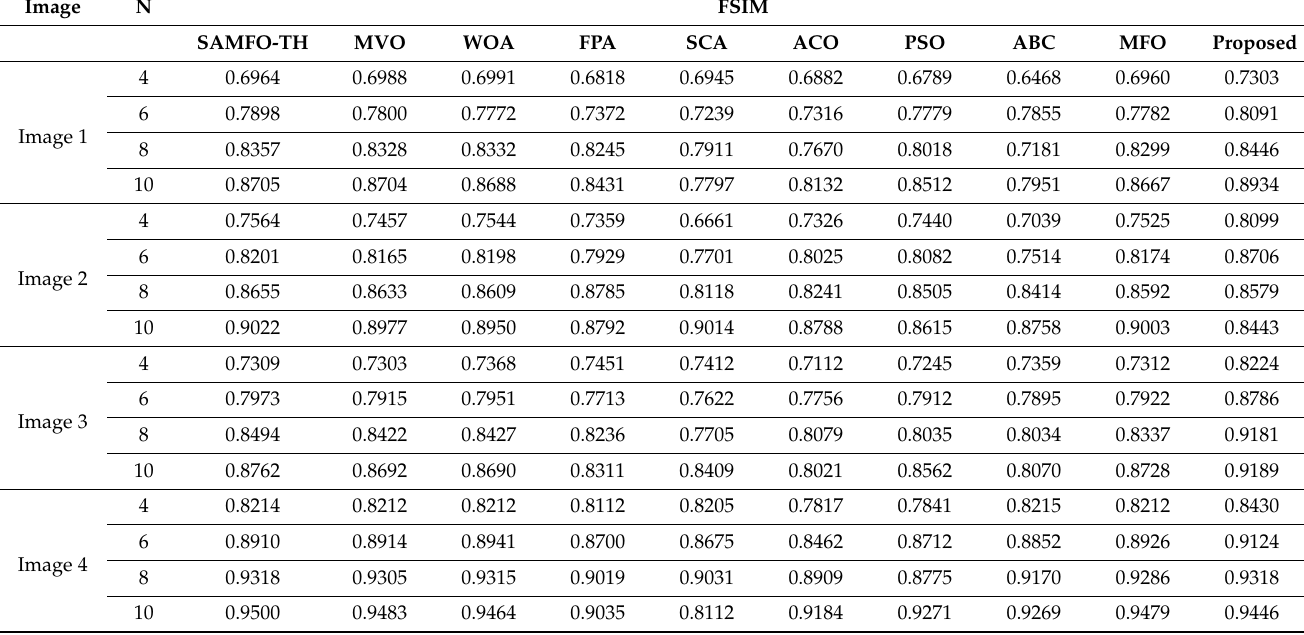
Table 12. Comparison of FSIM computed by SAMFO-TH, MVO, WOA, FPA, SCA, ACO, PSO, ABC, and MFO with the proposed model using Otsu’s method with N = 4, 6, 8, and